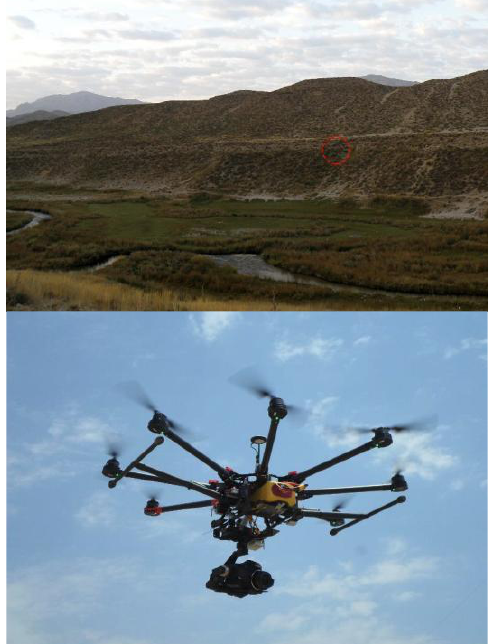
Figure 2. S1000 multirotor with Canon 5D MarkIII